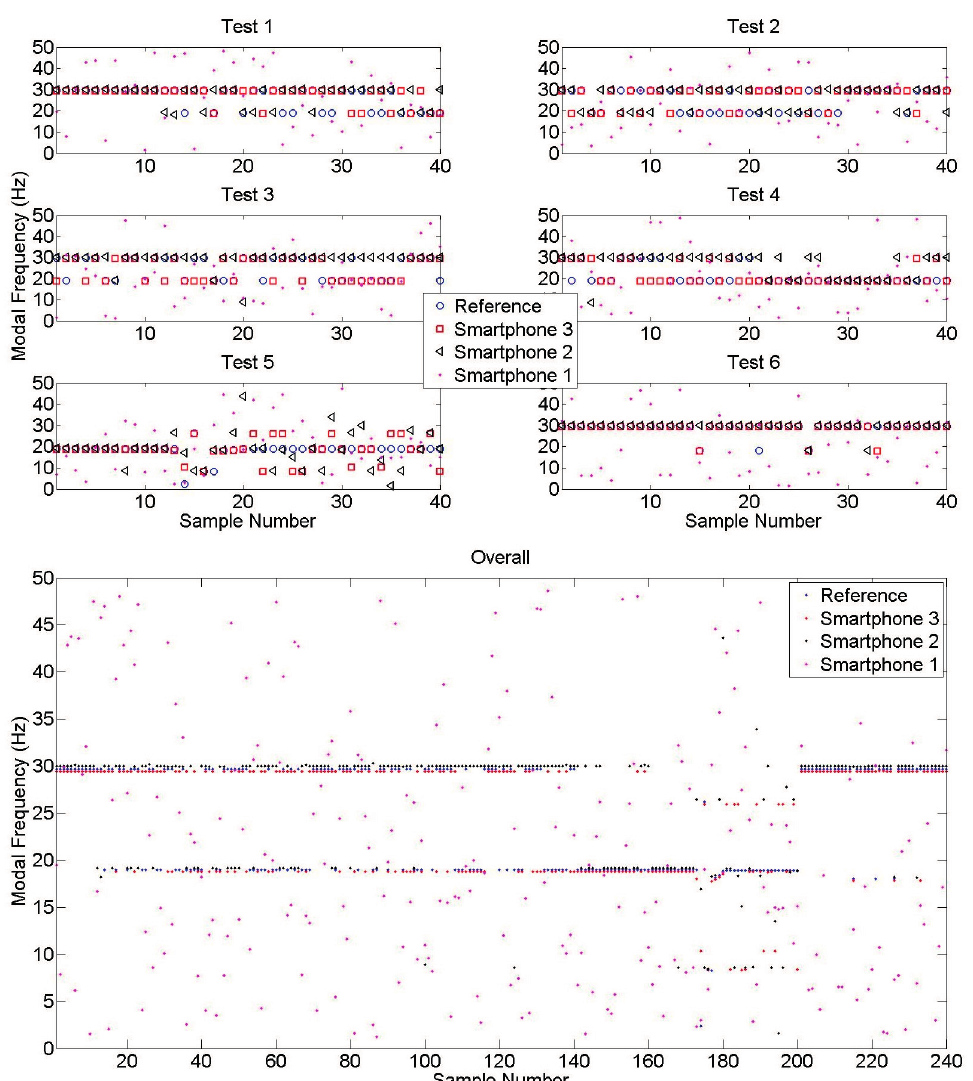
Figure 9. Identified frequencies obtained from different